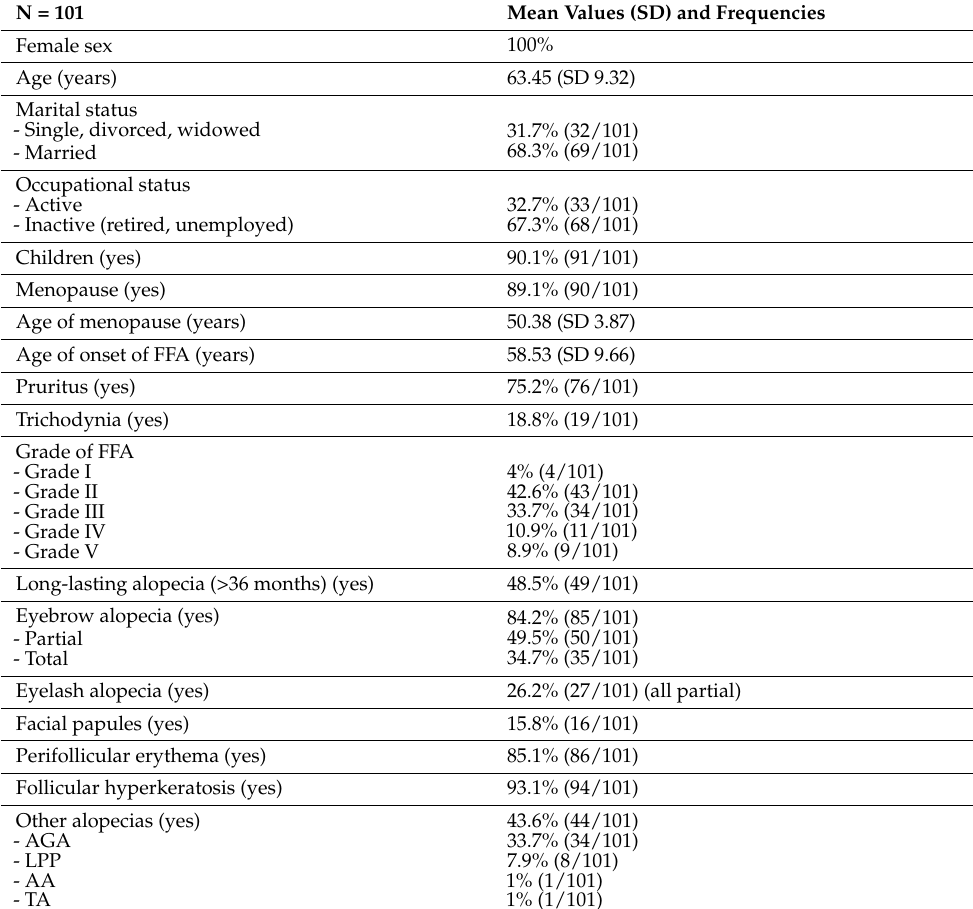
Table 1. Additional data about FFA